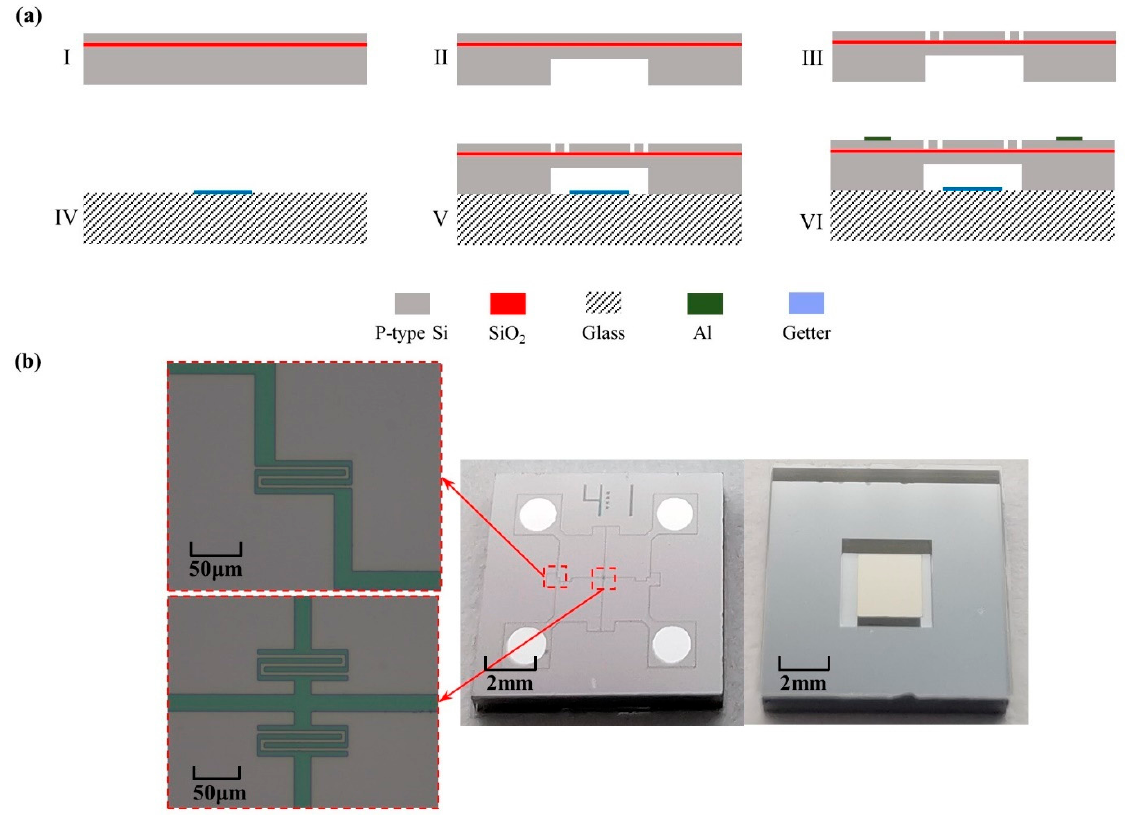
Figure 6. Fabrication of the developed piezoresistive pressure sensor with optimized positions of piezoresistors: ( a ) Fabrication processes include key steps of: ( Ⅰ ) cleaning the SOI wafer, ( Ⅱ ) etching the handle layer to form the vacuum cavity, ( Ⅲ ) etching the device layer to form the Wheatstone bridge, ( Ⅳ ) evaporating the getter, ( Ⅴ ) anodic bonding and ( Ⅵ ) evaporating Al electrodes; ( b ) The front and back views of the fabricated sensor with the details of piezoresistors.